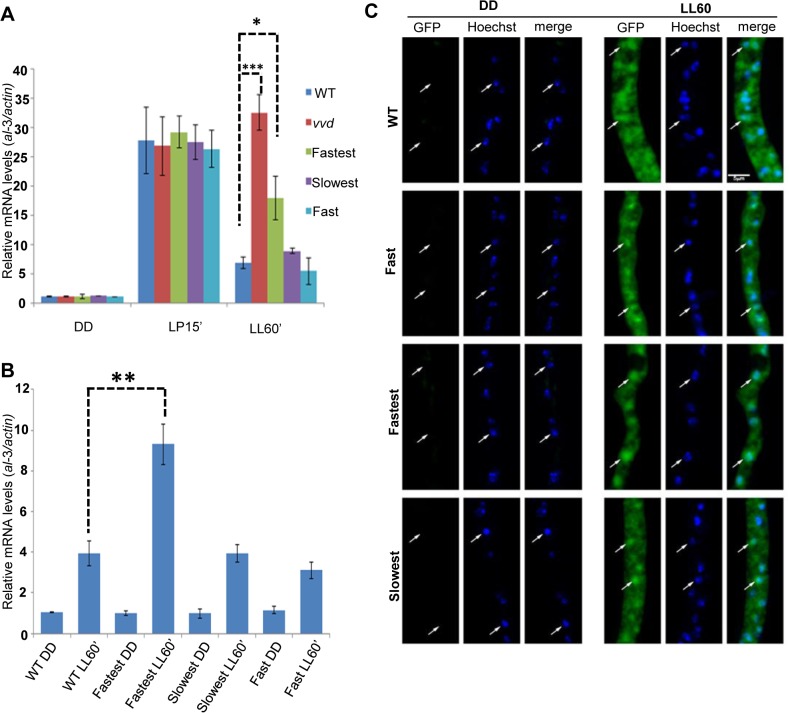
Photoadaptation defect exists at low light intensity and mutations do not effect nuclear localization of VVD.(A) Strains (n = 3) were exposed (after 48 hours in dark) to very low light intensity blue light (~1.5 μM m-2s-1 of blue light) for 15 minutes and 60 minutes to study light response and photoadaptation via al-3 gene expression. (B) N-terminal GFP tagged VVD mutant strains were created for sub-localization studies and photoadaptation defect was tested after 60 minute bright white light(40 μM m-2s-1) exposure in these strains using al-3 expression as readout (n = 3). (C) Fixed cell microscopy qualitatively shows that the mutants retain the ability to localize VVD protein to the nucleus after exposure to white light (40 μM m-2s-1) induces expression. Asterisks indicate statistical significance as determined by an unpaired t test. *P<0.05, **P<0.01, ***P < 0.001.